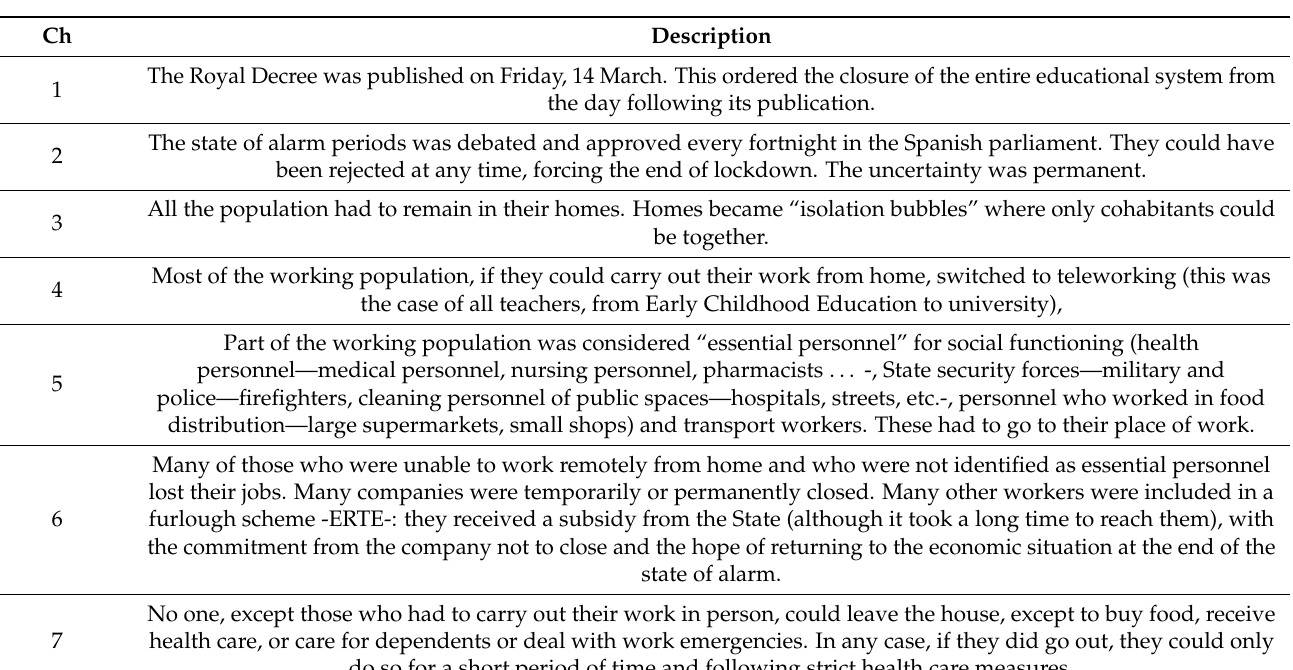
Table 1. Synthesis of characteristics (Ch) of the lockdown that was carried out in Spain between